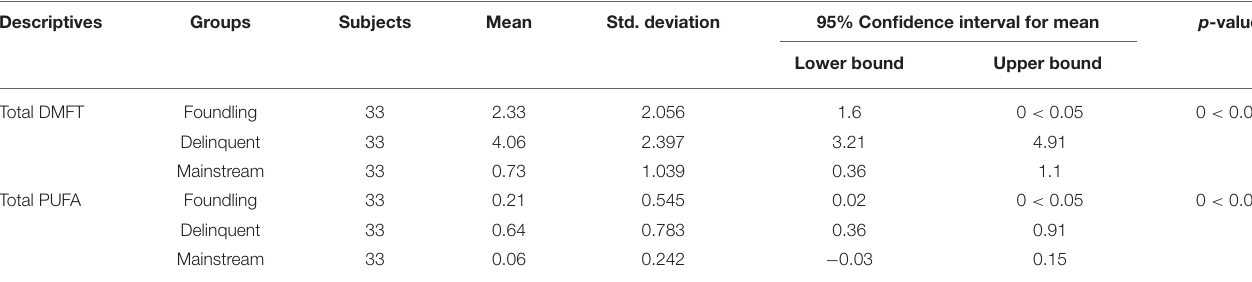
TABLE 4 | The mean prevalence of DMFT and PUFA score in foundling, delinquent and mainstream children groups.